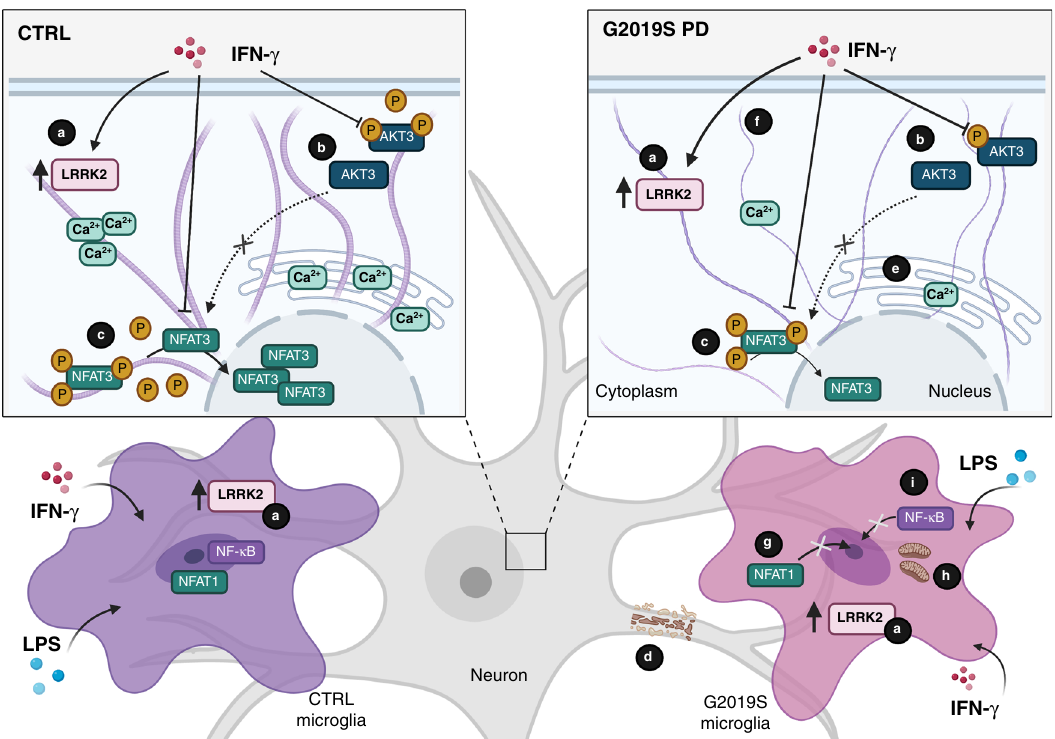
Fig. 7 Interferon- γ signaling synergizes with LRRK2 in human neurons and microglia. IFN- γ response is conserved in DA neurons, and IFN- γ induces LRRK2 expression in DA neurons and microglia ( a ). The PD-associated mutation LRRK2 G2019S sensitizes DA neurons to IFN- γ by decreasing AKT phosphorylation ( b ) and suppressing NFAT nuclear shuttling ( c ) that, in turn, leads to defects in neurite outgrowth ( d ). LRRK2-dependent defects of NFAT translocation are linked to defects in calcium buffering capacity ( e ) and possibly to an increased complexity of the microtubule network ( f ). Defects in NFAT shuttling are also observed in LRRK2 G2019S microglia ( g ), which display a more activated phenotype upon stimulation. LRRK2 G2019S modulates microglia activation by interfering with the metabolic switch toward glycolysis that normally occurs upon mononuclear phagocyte activation ( h ) and impairing NF- κ B p65 nuclear translocation upon stimulation with IFN- γ or LPS ( i Experiments with microglial-conditioned medium (MCM) . The conditioned medium was collected after 24 h from untreated or 100 ng/mL LPS-activated microglia. MCM was then fi ltered, diluted 1:1 with neuronal medium, and applied to neurons. Cells were fi xed after 48h and subjected to neurite length assay. THP-1 experiments . Human THP-1 cell lines were purchased from Sigma-Aldrich and cultured in RPMI 1640 (Life Technologies), 2mM GlutaMAX, and 10% FBS.